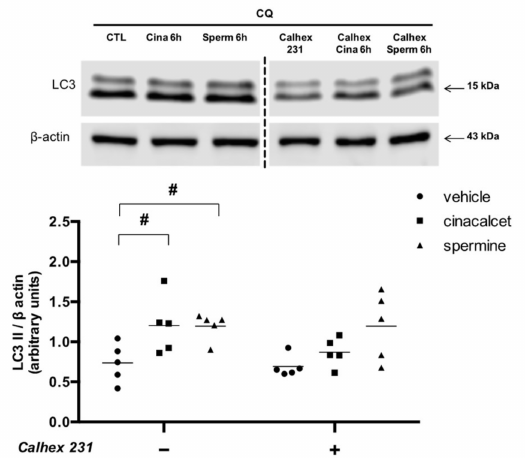
Figure 4. Cinacalcet- and spermine-induced elevation in autophagy is abolished by CaSR inhibition in visceral adipose tissue explants. Protein expression was determined after 6 h exposure to 2 µ M cinacalcet or 100 µ M spermine with or without 10 µ M calhex 231 preincubation (1 h) and presence thereafter. All conditions were exposed to 20 µ M chloroquine (CQ) during the last 2–3 h to determine the protein levels under autophagy flux inhibition. Expression of protein abundance was normalized by β -actin. Di ff erences between vehicle and treated conditions were determined by two-way ANOVA and Holm–Sidak’s multiple comparison post-hoc test. # p < 0.05 and the dots represent each independent experiment (n = 5), corresponding to a di ff erent adipose tissue (AT) explant donor. The two parts of the membrane represent the same experiment and were processed in a single western